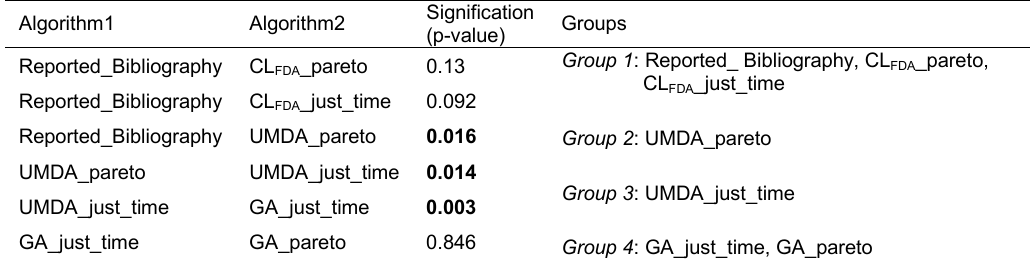
Table 12. Comparison results using Wilcoxon test, variable Stddev_Makespan